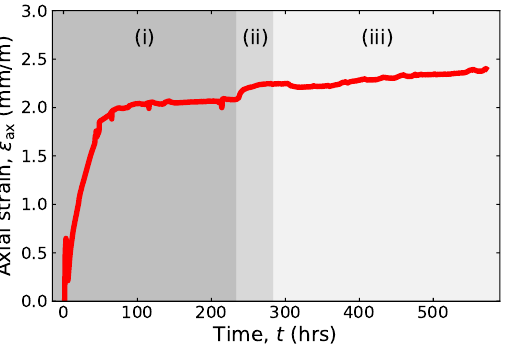
Figure 7. Axial strain (cid:101) ax versus time t . Roman numbering combined with the grayscale background indicates the respective phases of fluid exposure: Phase (i), Phase (ii), and Phase (iii). Figure 8 features Young’s modulus E V and Poisson’s ratio ν VH as a function of time: (a) includes the entire experiment while (b) is superimposed from 220 to 330 h with narrower y-axes. As the signals are stabilized with time (Figure 8b), subsequent phases are sequentially initiated. Phase (i) is primarily used for stability and as reference to determine changes in mechanical properties. Phase (ii) introduced at approximately 234 h decreased E V by 1.57%. Phase (iii) introduced at 283 h had an initial stiffening effect ( E V increased by 1.04%) for the first 80 h after influx before plateauing at 364 h with approximately constant E V until the end. Poisson’s ratio ν VH remained resilient to the different phases as a function of time without any noteworthy changes. Figure 9 includes ultrasonic P- and S-wave velocities at 500 kHz recorded every 900 s for the entirety of the test. Despite an accelerated reduction after introducing the brine–CO 2 combination, a proclivity towards steady declination of both V P and V S is the noteworthiest feature during all three phases. 0 0